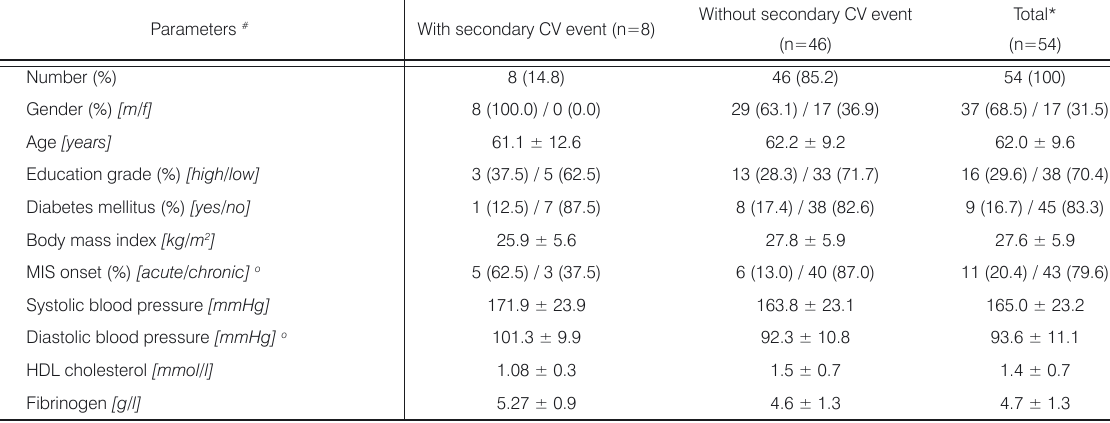
Table 1. Main demographic and clinical characteristics of MIS patients, followed prospectively for 12